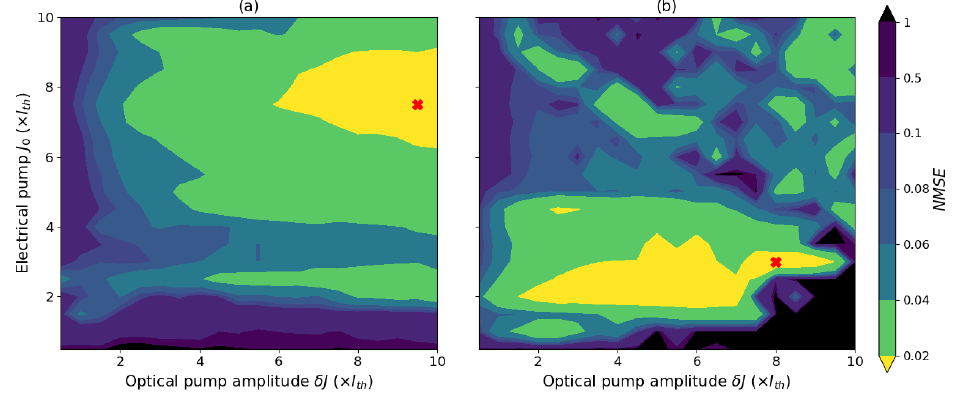
Figure 5. Santa Fe timeseries prediction performance, indicated by the NMSE , color-coded unto the parameter space spanned by the electrical pump J 0 and the optical pump amplitude δ J for ( a ) η = 1 ns − 1 , τ D = 150 ps, N = 95 and θ = 5.5 ps and ( b ) η = 100 ns − 1 , τ D = 15 ps, N = 55 and θ = 7.5 ps. The red crosses denote the minimum NMSE achieved over the scanned